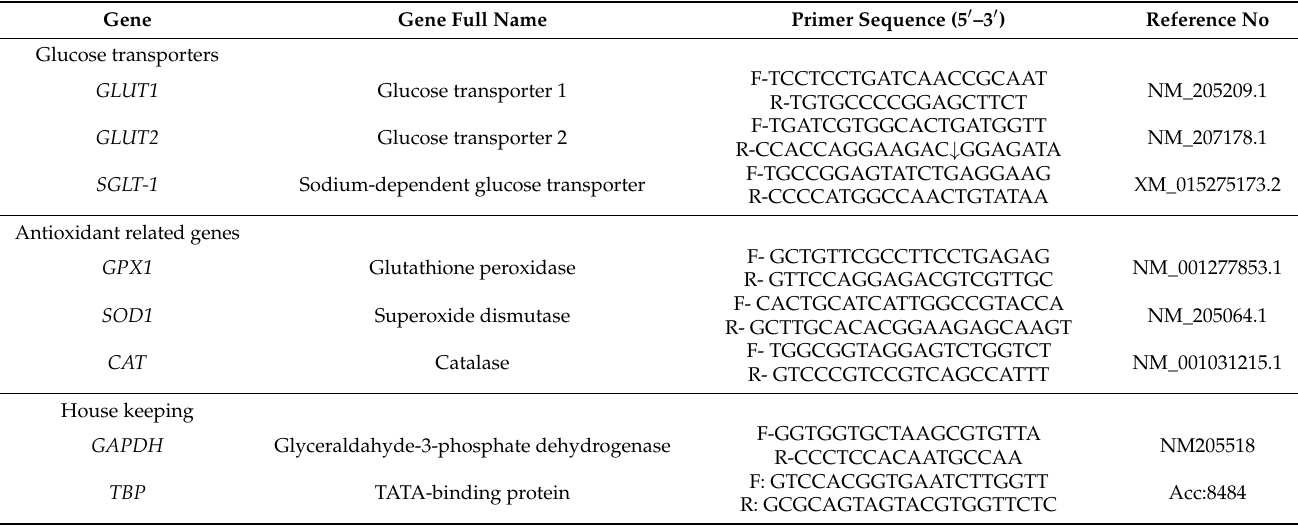
Table 2. Primer sequences and target genes used for Q-PCR